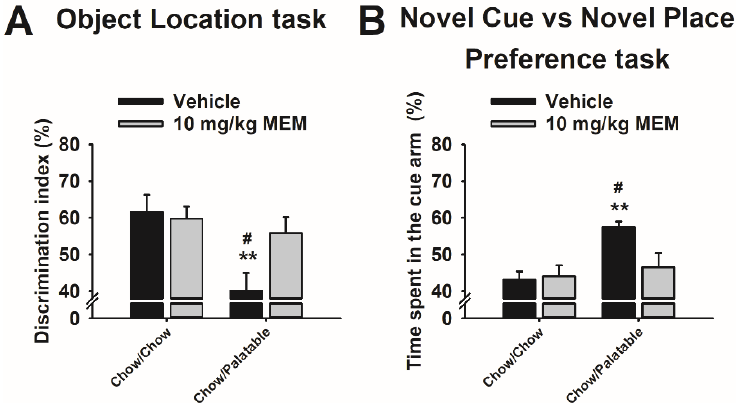
Figure 4. E ff ects of systemic administration of memantine (0, 10 mg / kg) on ( A ) Object Place Recognition Figure 4. Effects of systemic administration of memantine (0, 10 mg/kg) on ( A ) Object Place task and ( B ) Novel Cue vs. Novel Place Preference (NC-NP Preference) task during the C Phase Recognition task and ( B ) Novel Cue vs. Novel Place Preference (NC ‐ NP Preference) task during the of Chow / Chow and Chow / Palatable male Wistar rats undergoing the ad libitum diet alternation C Phase of Chow/Chow and Chow/Palatable male Wistar rats undergoing the ad libitum diet ( n = 6–10 / group). Data show M ± SEM. # p ≤ 0.05, Chow / Palatable in C phase vs. Chow / Palatable in P alternation ( n = 6–10/group). Data show M ±SEM. # p ≤ 0.05, Chow/Palatable in C phase vs. phase; ** p ≤ 0.01 Chow / Palatable in C phase vs. Chow / Chow in C phase. Chow/Palatable in P phase; ** p ≤ 0.01 Chow/Palatable in C phase vs. Chow/Chow in C phase.